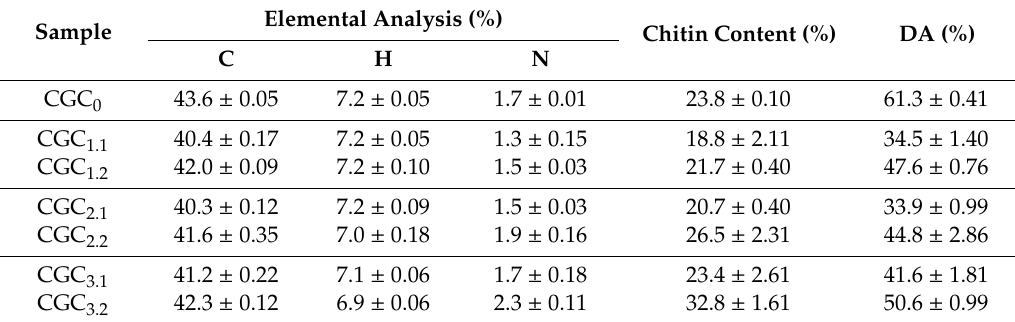
Table 2. Chemical characterization of the original CGC (CGC 0 ) and polymer samples regenerated from the NaOH / urea solvent systems (DA, degree of